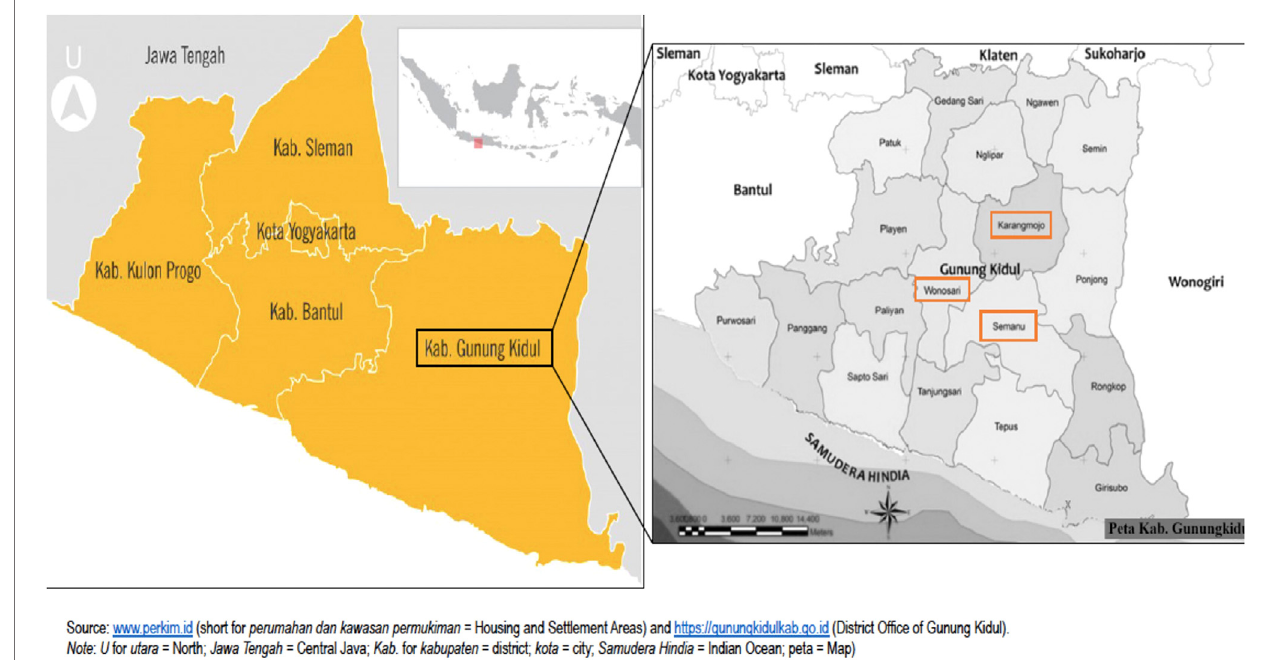
FIGURE 2 | Research locations: four rural villages in the Semanu, Karangmojo and Wonosari districts in the Gunung Kidul Regency, Yogyakarta Special Region, Indonesia.